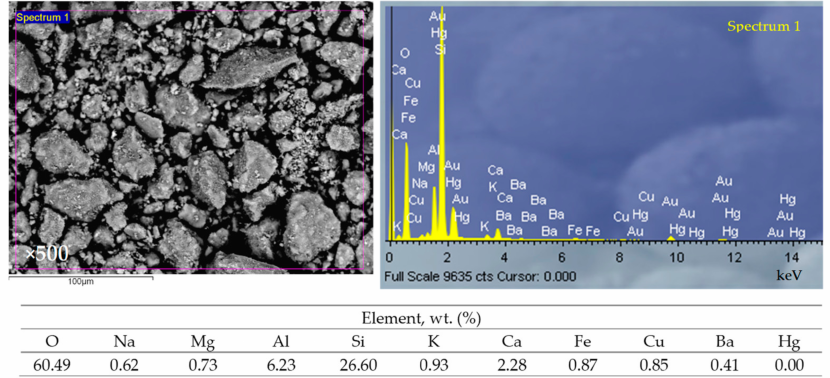
Figure 14. SEM image and EDS results for NZ of particle size < 0.04 mm after sorption of total mercury leached for pH o of ultrapure water of 6.32.